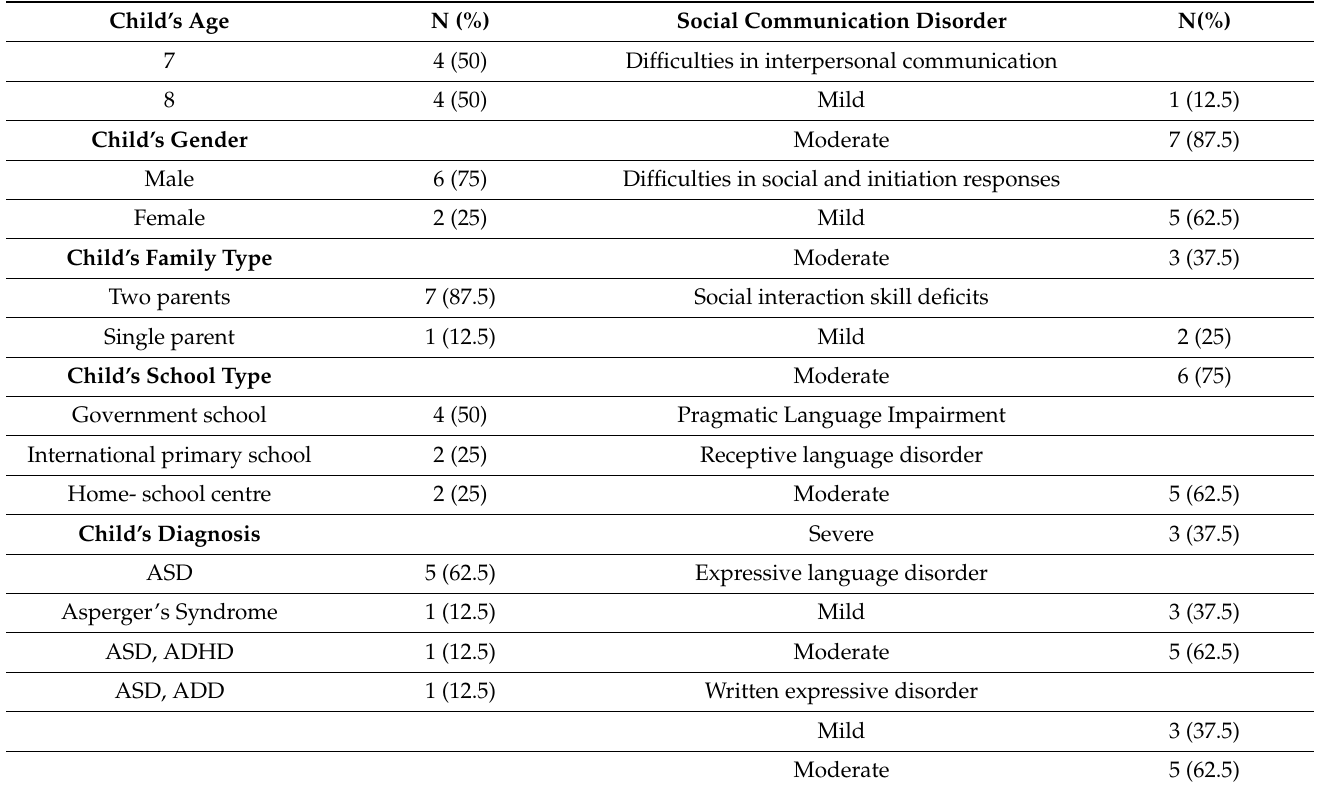
Table 2. Demographic Characteristics of Parents’